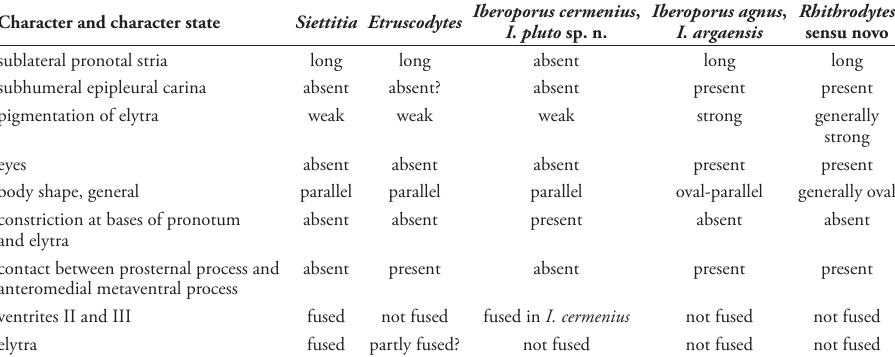
Table 3. Summary comparison of some character states among the taxa of the Siettitia group of genera (character states of Etruscodytes obtained from Mazza et al.